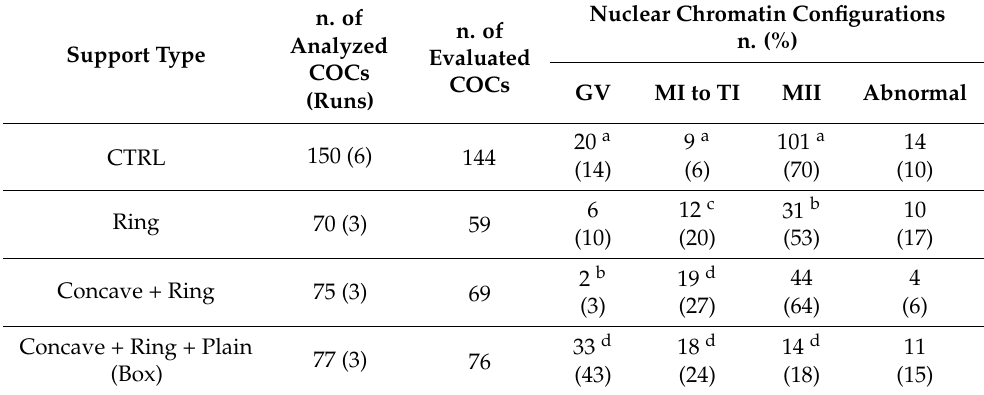
Table 4. Effects of mIVM with biocompatible supports on sheep oocyte nuclear maturation.